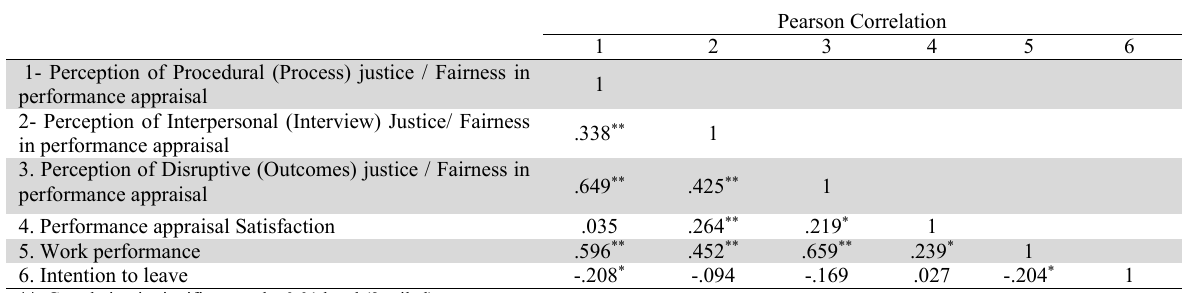
The results of the correlations